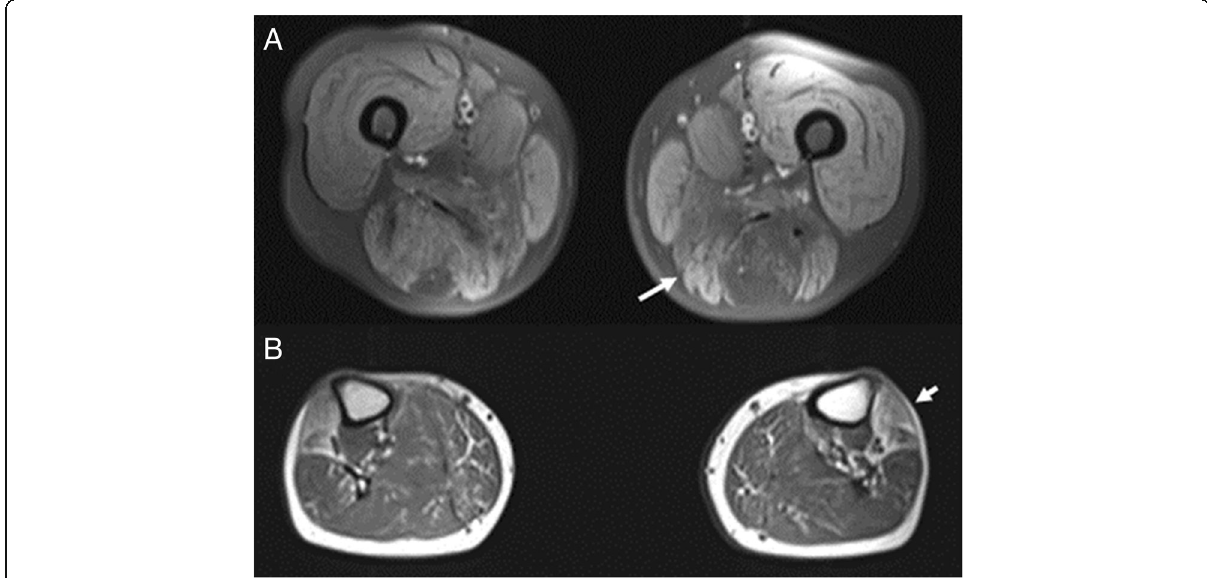
Fig. 2 Axial MRI of the thigh ( a ) and the calf ( b ). a . T1 fatsat image shows fatty degeneration of muscles in the posterior compartment (dark, arrow). b . T1 image shows degeneration of anterior tibial muscles (arrow) and fatty infiltration of medial gastrocnemius